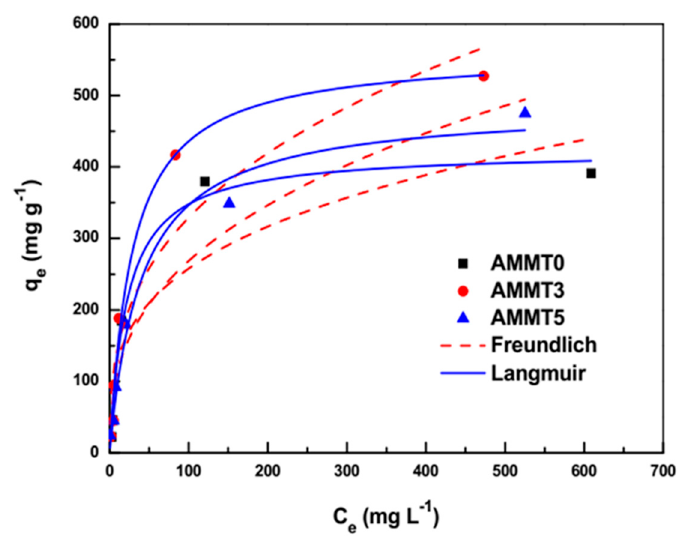
Figure 8. Batch adsorption data of AMMT0, AMMT3, and AMMT5 and non-linear fitting of isotherm models. Batch mode experiments were completed at MB concentrations ranging from 25 to 1000 mg L − 1 . Adsorbent dosage, MB volume, contact time, and reaction temperature were adjusted to 0.01 g, 0.01 L, 24 h, and 25 ◦ C, respectively. Table 1. Langmuir and Freundlich isotherm constants for MB adsorption onto composite